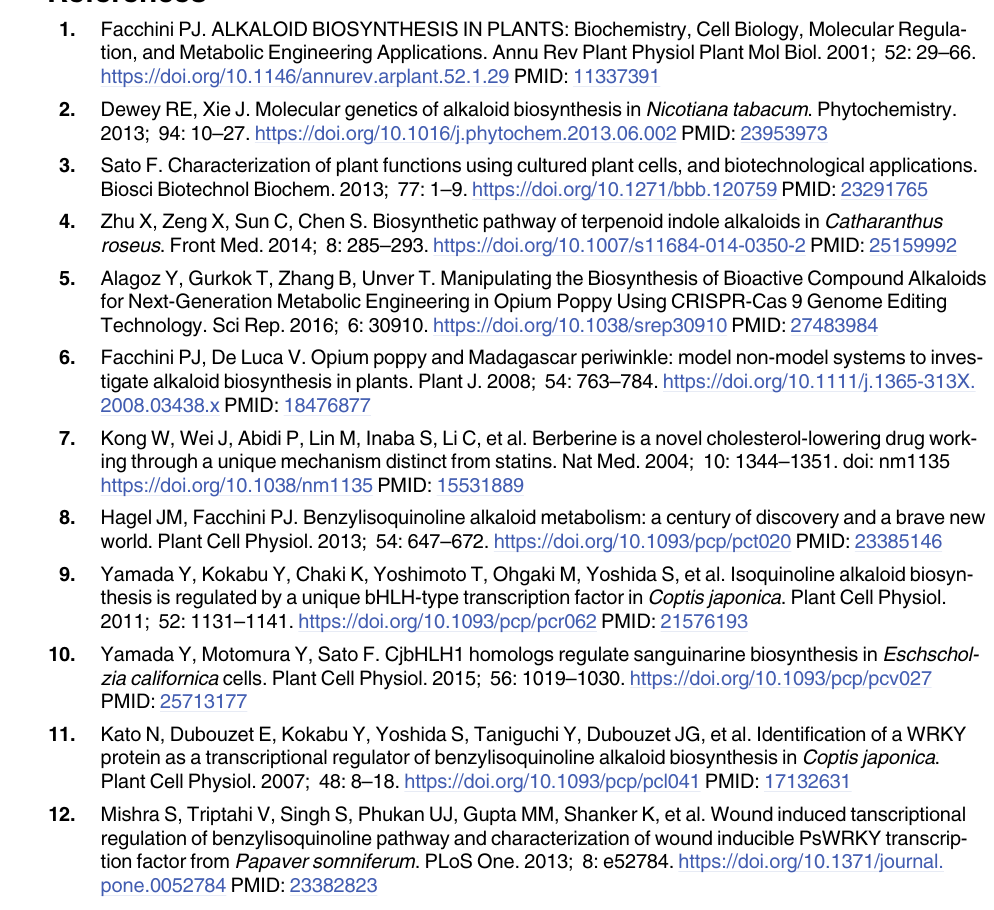
S1 Table. Primers for quantitative RT-PCR of target